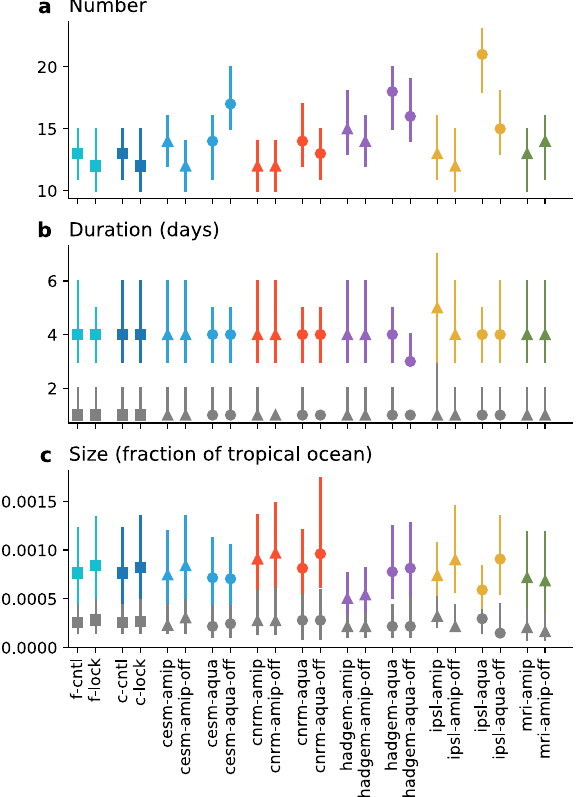
Fig. 6 Summary of extreme tropical ocean precipitation events. a Median number, b median duration, and c median size. Gray markers show the median duration and size of all events, while colors in those panels exclude events that are shorter than 2 days or smaller than 2 grid cells; colors indicate model, as in other fi gures. Error bars show the interquartile range. The simulations are paired into experiments